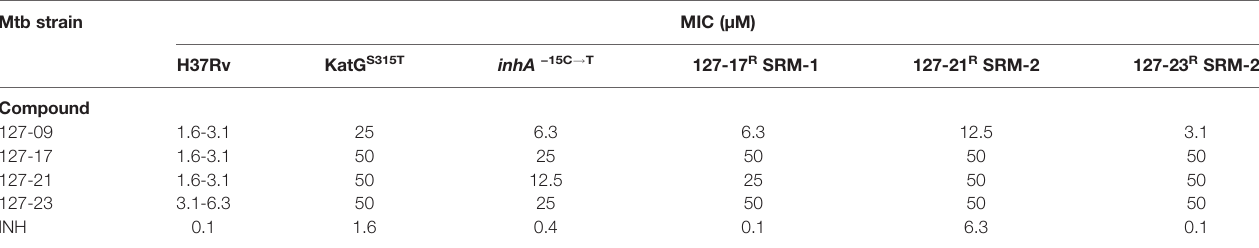
TABLE 4 | Evaluation of cross resistance of pyridine carboxamide analogues against KatG S315T , inhA − 15C ! T and spontaneous drug resistant mutants. Mtb strain MIC